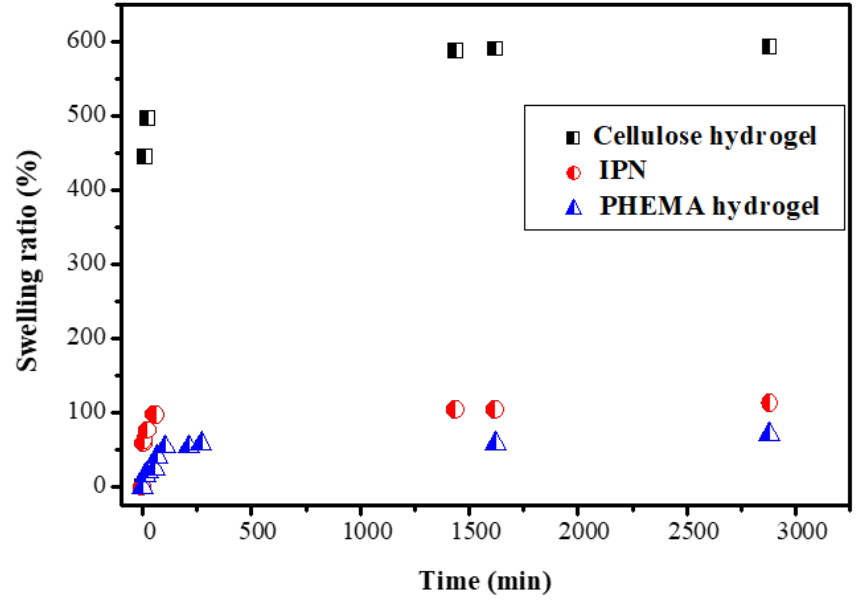
Figure 12. Swelling kinetic in water medium of the IPN b (ECH 7% and HEMA 200%), cellulose (ECH 7%) and PHEMA hydrogels.